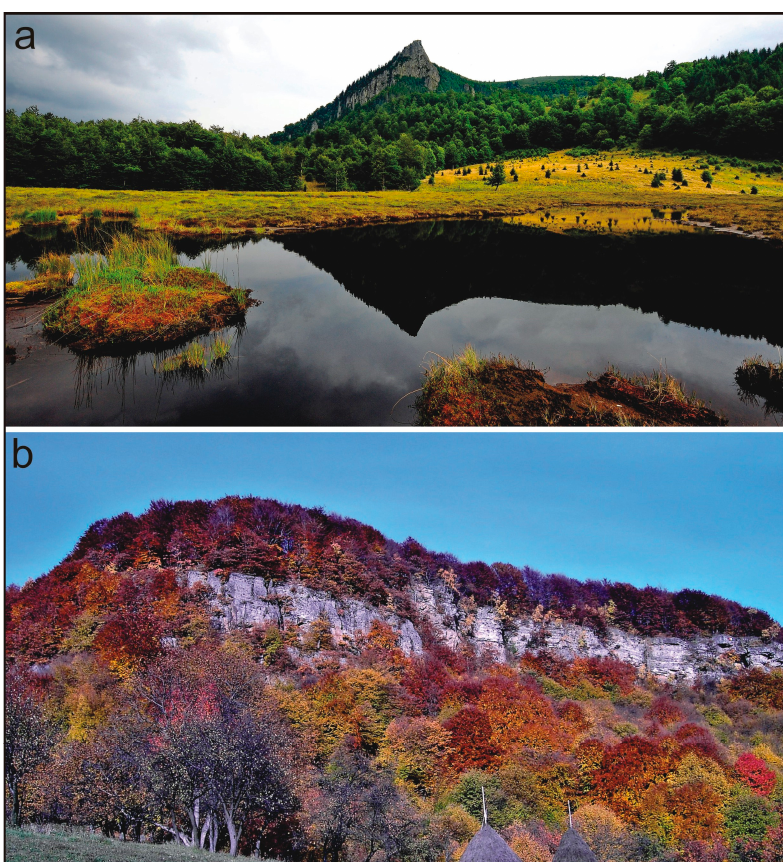
Figure 23. European NATURA 2000 network site Gutâi Creasta Coco ş ului (“Rooster’s Crest”), including the natural protected area with the same name ( a ) (Photo credit: Péter Lengyel). Piatra Ro ş ie (Red Stone) Hill impressive escarpment in in-situ and resedimented hyaloclastites (with erosion caves in the upper part) of the D ă ne ş ti–Cet ăţ ele composite dome ( b ) (Photo credit: Alexandrina Fülöp).